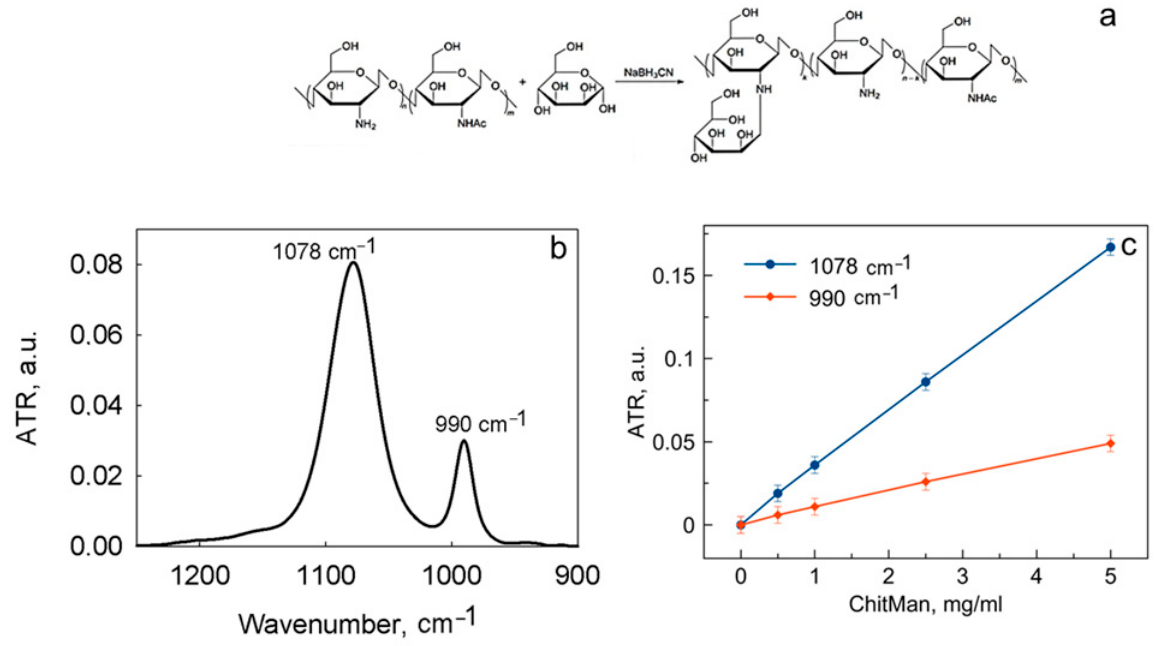
Figure 1. Chitosan–mannose conjugates: ( a ) Synthesis ( b ) ATR-FTIR spectrum of ChitMan. 0.02 M Na-phosphate buffer solution, pH 7.4, 22°. ( c ) Calibration curves for 1078 cm − 1 and 990 cm − 1 bands in ATR-FTIR spectrum of ChitMan (SD, n = 3). 0.02 M Na-phosphate buffer solution, pH 7.4, 22°.